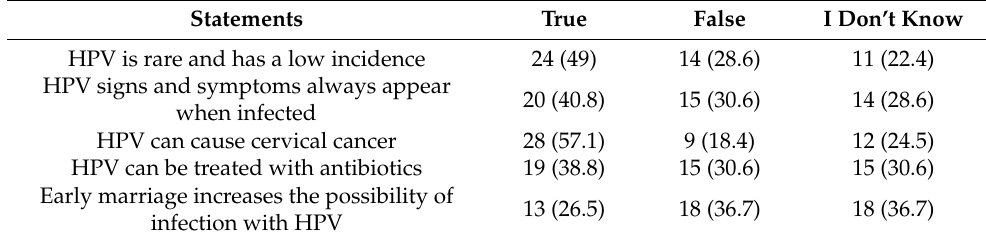
Table 3. Knowledge of participants on human papillomavirus.